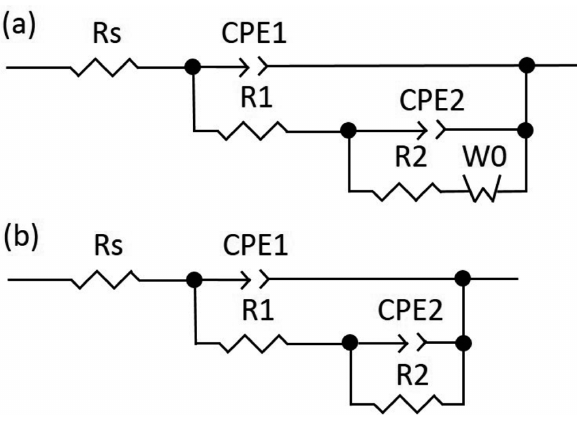
Figure 9: Equivalent circuit model for fitting EIS